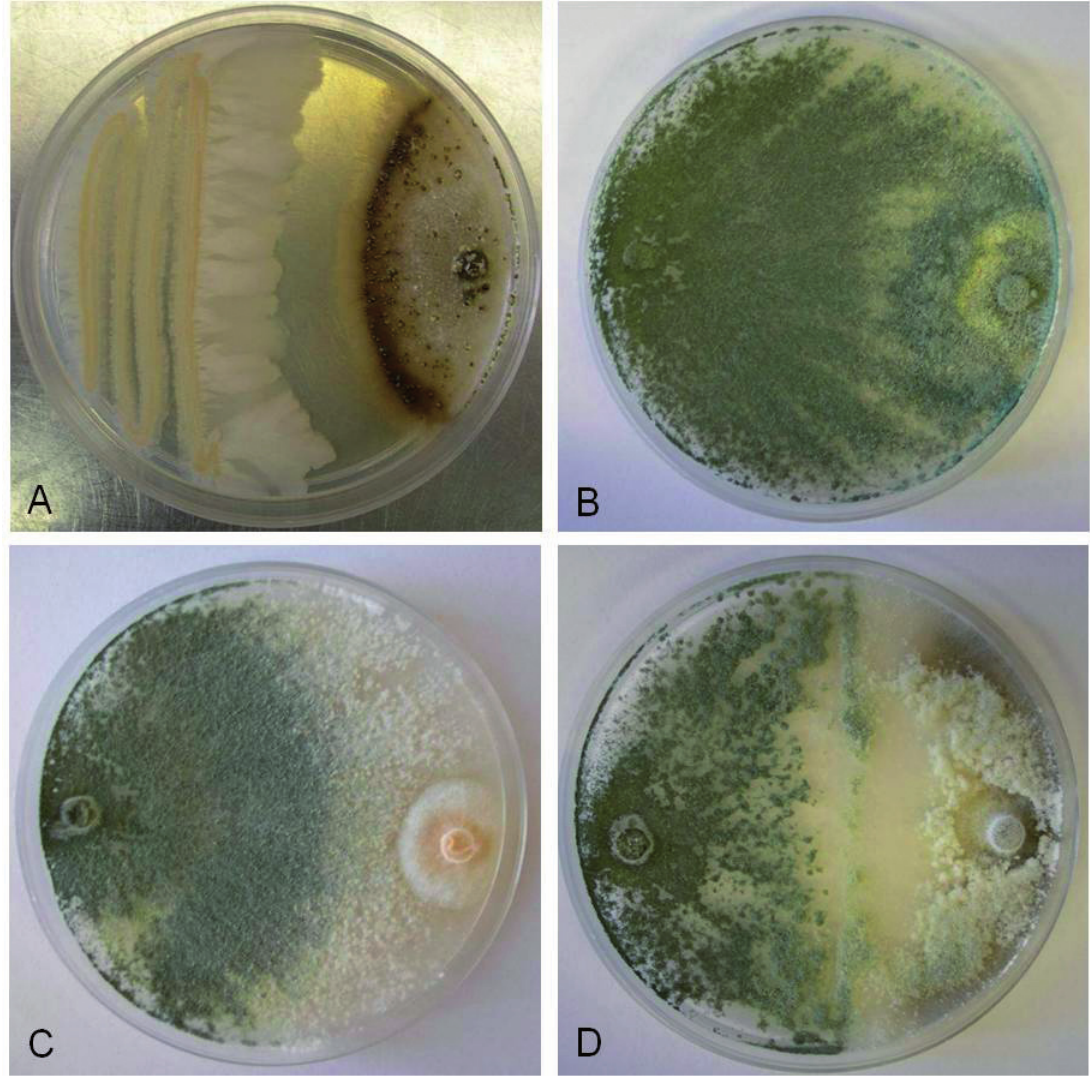
Figure 1. Macroscopic interactions observed on PDA medium. A) Inhibition zone ( B. subtilis and Ph. viticola ). B) Overgrowth (Biotricho and E. lata ). C) Growth inhibition (USPP-T1 and Pm. aleophilum ). D) Arrested growth (Ag 8 and L. theobromae